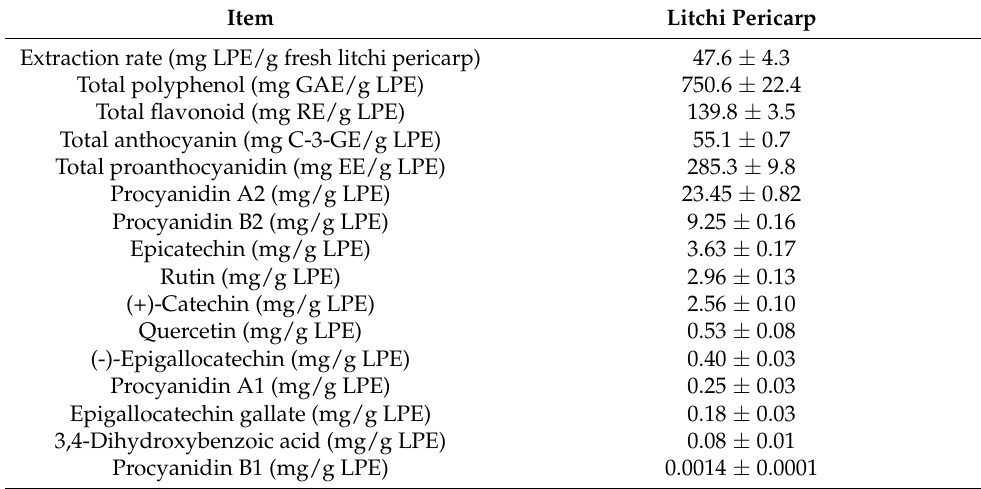
anthocyanin was obtained as cyanidin-3-glucoside equivalents (mg C-3-G E)/g LPE. Total proanthocyanidin was obtained as epicatechin equivalent (mg EE/g